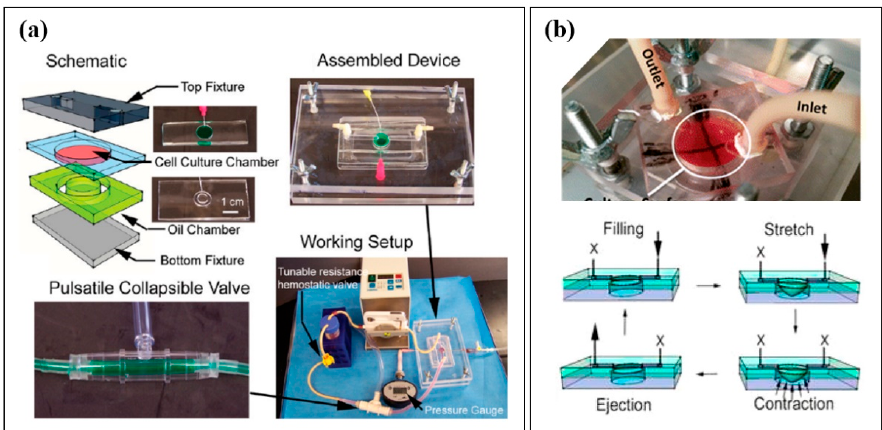
Figure 2. ( a ) Microfluidic Cardiac Cell Culture Model developed by Giridharan et al., along with a schematic diagram, images of an assembled device, pulsatile collapsible valve, and the complete working setup. Reproduced with permission from the American Chemical Society [32]. ( b ) Biomimetic Cardiac Tissue Model (BCTM), developed by Rogers et al., depicting the cardiac cell culture chamber and schematic diagrams representing how the BCTM reproduces the cardiac cycle. Arrows represent the direction of fluid flow and membrane stretch. Reproduced with permission from the American Chemical Society [34].